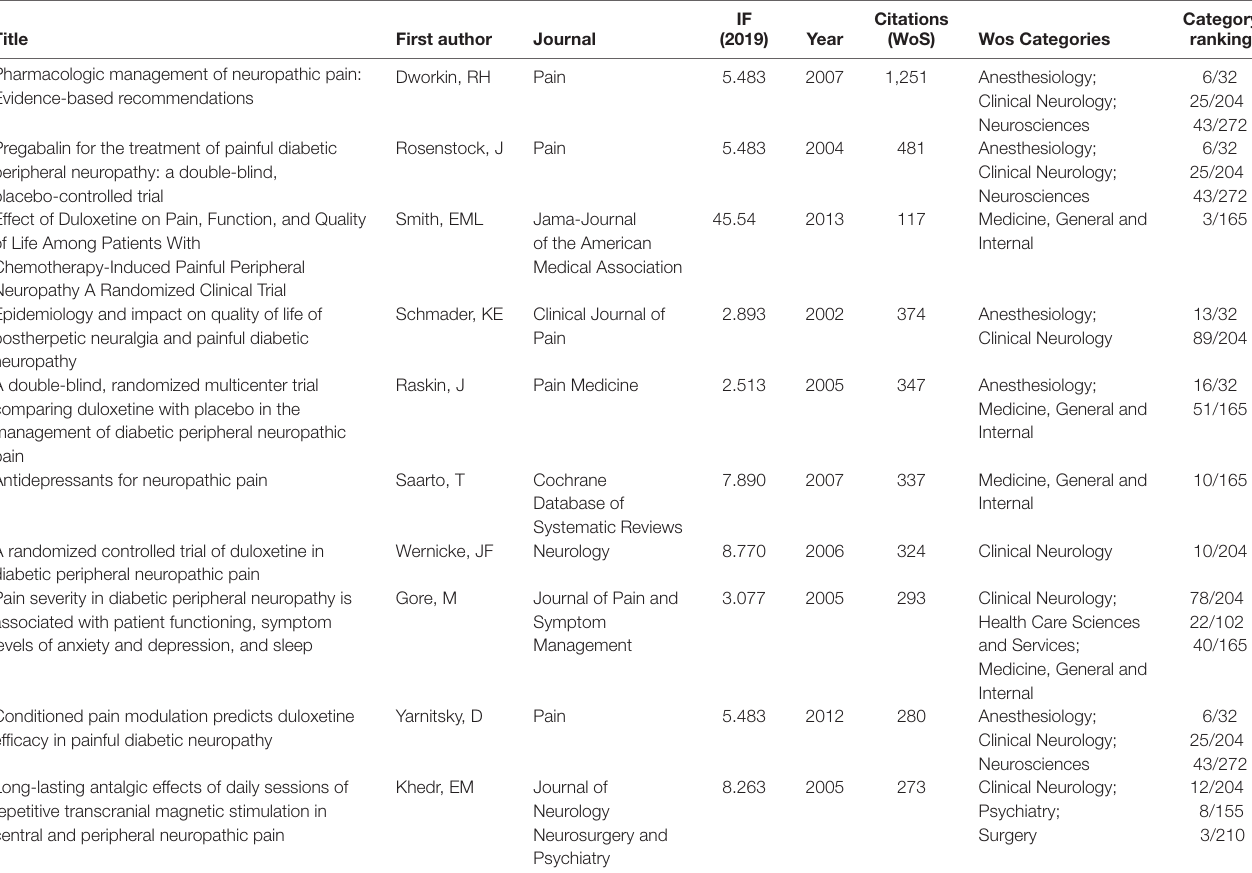
TABLE 2 | The top 10 articles with the most citations on neuropathic pain associated with anxiety or depression